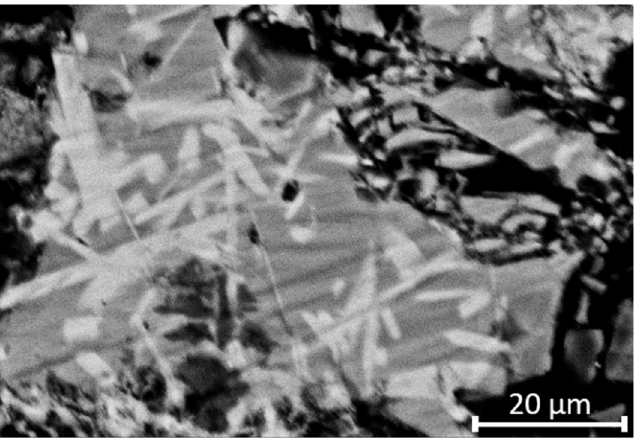
Figure 7. SEM-BS image of a green portion observed in sample B where it is possible to observe two-phase system (light gray is wollastonite, dark gray is high temperature polymorphs of silica).